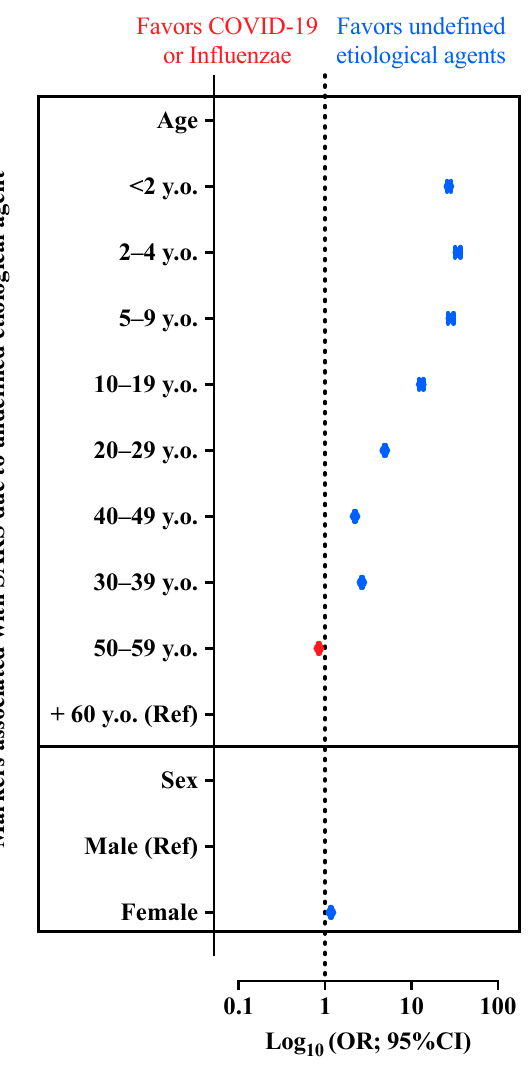
Figure 6. Odds ratio (OR) and 95% confidence interval (95% CI) for the association between patients with severe acute respiratory syndrome (SARS) due to undefined etiological agent compared with patients with SARS due to Coronavirus Disease (COVID-19) or Influenzae virus infection regarding sex and age. Ref, reference.